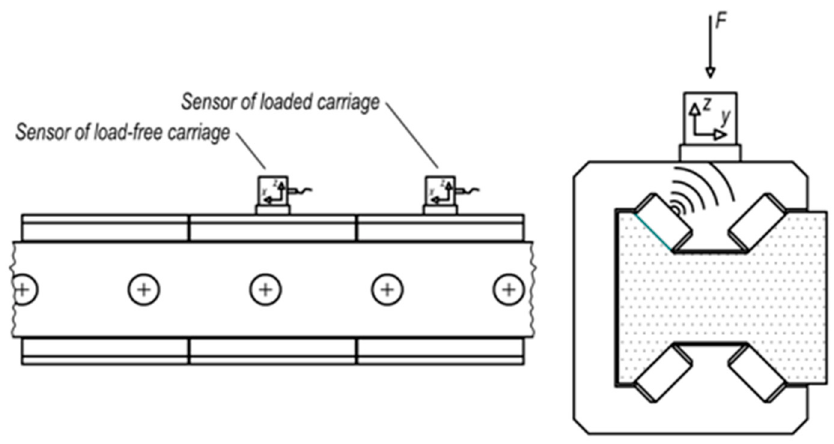
Figure 8. The scheme of sensor position against the damage.